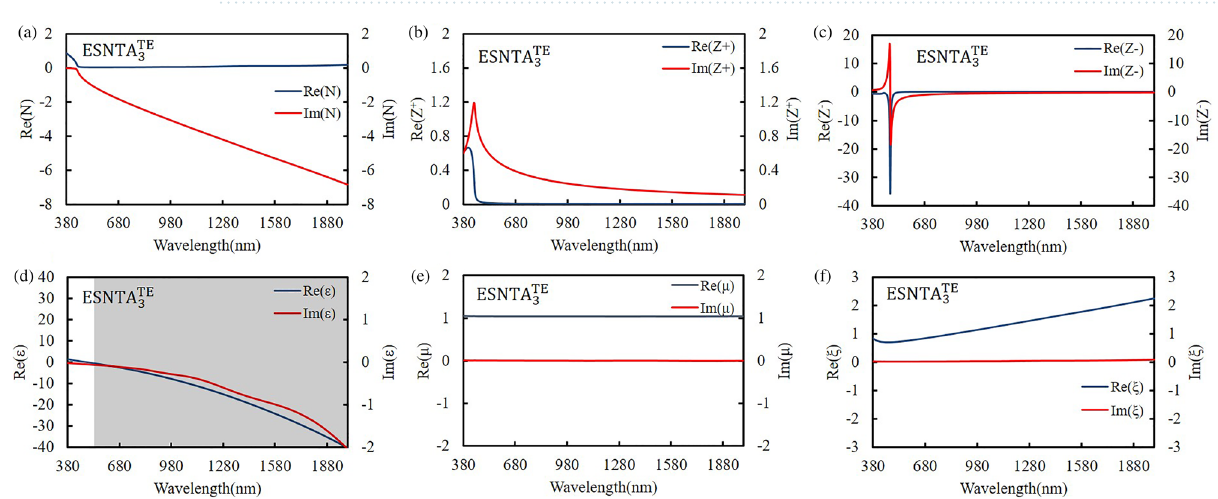
Figure 13. Retrieved ( a ) refractive index, ( b ) positive impedance, ( c ) negative impedance, (d) permittivity, ( e ) permeability, and ( f ) bianisotropy parameter for ESNTA 3 TE